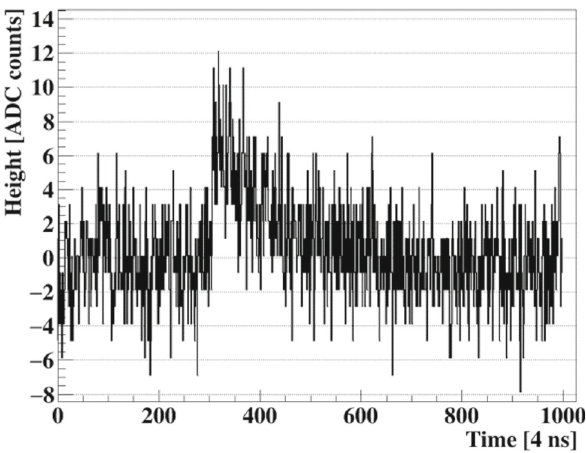
Fig. 4 A random single PE waveform from the top SiPM. The ones from the bottom SiPM are very similar